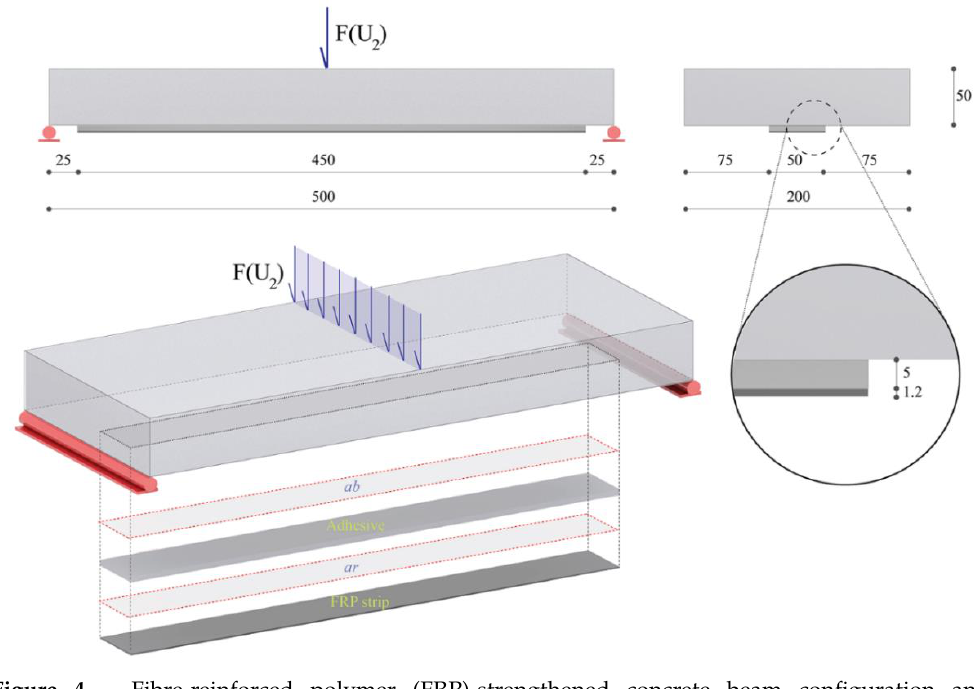
Figure 4. Fibre-reinforced polymer (FRP)-strengthened concrete beam configuration and loading scheme.